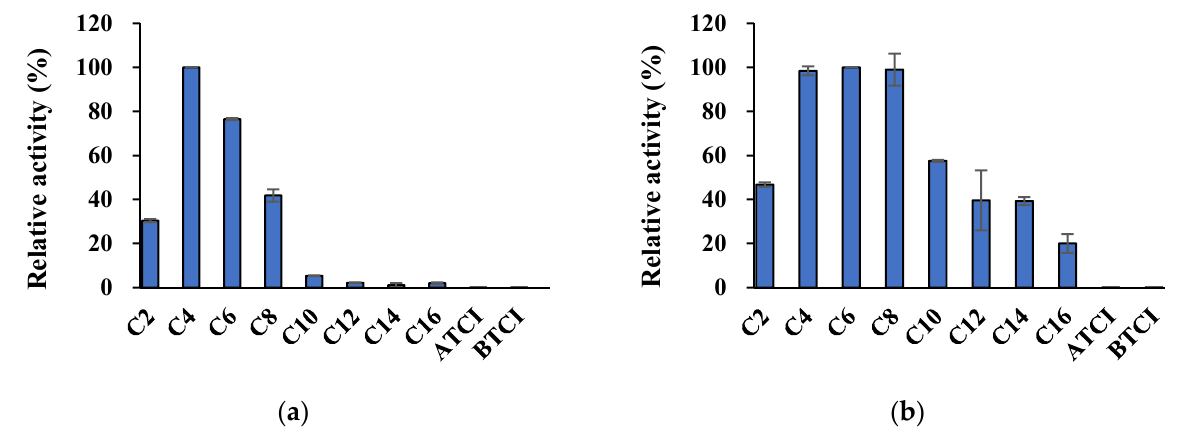
Figure 7. Substrate specificities of Est8L ( a ) and Est13L ( b ). The relative activities were calculated as percentages of the highest activity.